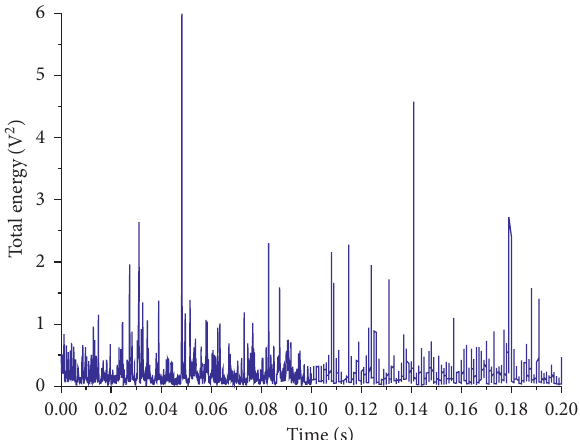
Figure 12: The total energy of swash plate wear for axial piston